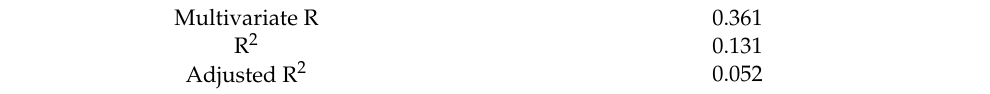
Table 9. Summary of coefficients of the optimal scaling model obtained by the descending method.